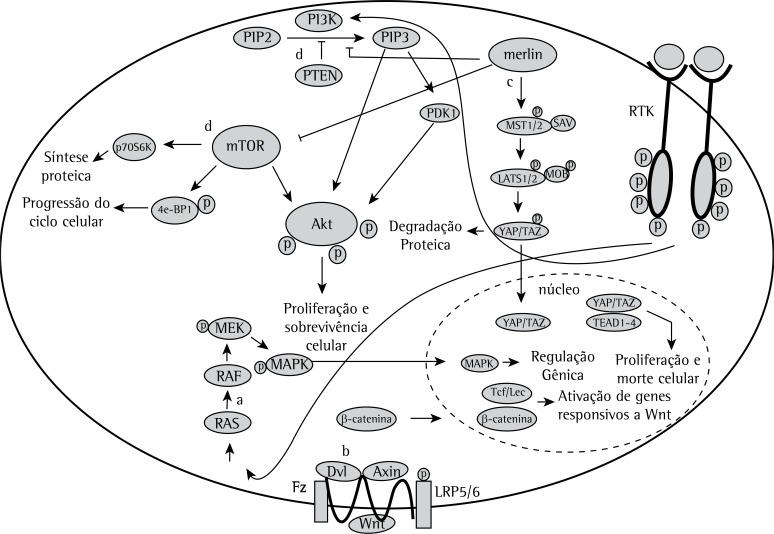
Vias bioquímicas mais comumente alteradas no mesotelioma maligno. Em a,
os receptores tirosina quinase são frequentemente ativados no mesotelioma
maligno, gerando assim um aumento das vias bioquímicas Ras e PI3K. A via Ras
ativa a Raf, a qual causa fosforilação de mitogen-activated protein kinase
kinase (MEK, quinase de proteína quinase ativada por mitógeno) que, por sua
vez, causa a fosforilação de mitogen-activated protein kinase (MAPK,
proteína quinase ativada por mitógeno), que migra para o núcleo, regulando
assim a expressão gênica. Em b, a via Wnt controla diversos processos
celulares, sendo que, na presença de um ligante Wnt, um complexo que envolve
as proteínas disheveled homolog (Dvl), Axin, frizzled (Fz) e low-density
lipoprotein receptor-related (LRP5/6, receptor relacionado a lipoproteína de
baixa densidade), leva a inibição da fosforilação da ß-catenina e de sua
degradação. Dessa forma, a ß-catenina migra para o núcleo, onde interage com
o complexo Tcf/Lef, levando assim a ativação de genes responsíveis. Em c, a
proteína merlin é codificada pelo NF2 e inibe a via PI3K e mTOR, atuando
como um regulador upstream da via Hippo. Através de um estímulo, uma cascata
bioquímica é iniciada, onde macrophage stimulating 1/2 (MST1/2, estimuladora
de macrófago 1/2) causa a fosforilação de salvador homolog 1 (SAV1, homólogo
salvador), large tumor suppressor 1/2 (LATS1/2, supressor de tumor grande) e
Mps one binder kinase 1 (MOB1, um ligante Mps quinase 1). O complexo MST1/2
e SAV1 causam a fosforilação de LATS1/2; já o complexo formado por LATS1/2 e
MOB1 interage diretamente e causa a fosforilação de YAP/TAZ, sendo que esse
último, quando fosforilado, leva a degradação proteica, enquanto em sua
forma desfosforilada, entra no núcleo e se liga aos fatores de transcrição
TEAD1-4 a fim de regular genes envolvidos na proliferação e morte celular.
Em d, a via PI3K/Akt/mTOR é ativada mediante a conversão de
phosphatidylinositol-3,4,5-trisphosphate (PIP3, fosfatidilinositol
trifosfato) em phosphatidylinositol 4,5-bisphosphate (PIP2,
fosfatidilinositol bifosfato), sendo que PTEN atua como um antagonista dessa
ativação. PIP3, pyruvate dehydrogenase kinase, isozyme 1 (PDK1, quinase
piruvato desidrogenase, isoenzima 1) e mammalian target of rapamycin (mTOR,
alvo da rapamicina em mamíferos) causam a fosforilação da proteína quinase B
(Akt), a qual, então ativada, atua em processos-chave na proliferação,
sobrevivência e motilidade celular.